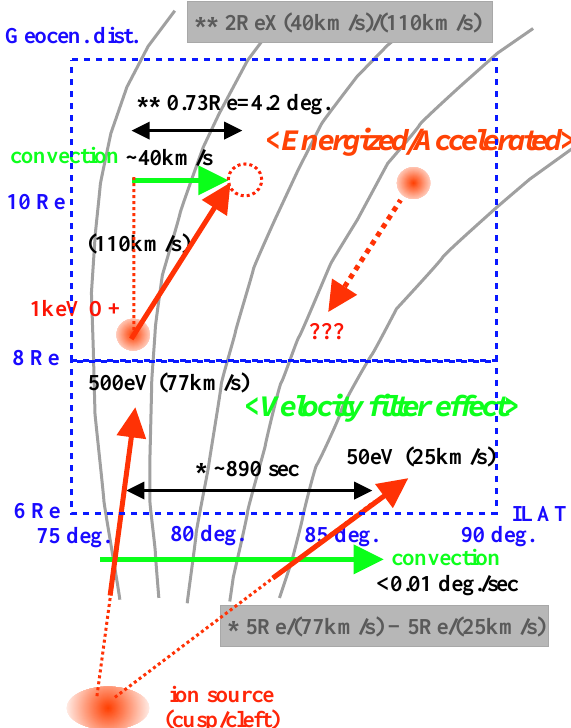
Fig. 4. The schematic (not scaled) of our conclusion. This sketch shows that we can explain outflowing O + ions in the polar region by the velocity filter effect below 8 R E geocentric distance, whereas the latitudinal distribution of O + ions above 10 R E cannot be ex- plained by the velocity filter effect only. Thus, we suggest that ad- ditional energization/acceleration occurs at high altitudes and high latitudes. Note the effects by geomagnetic activity, for example, K p dependence, are not taken into account in this